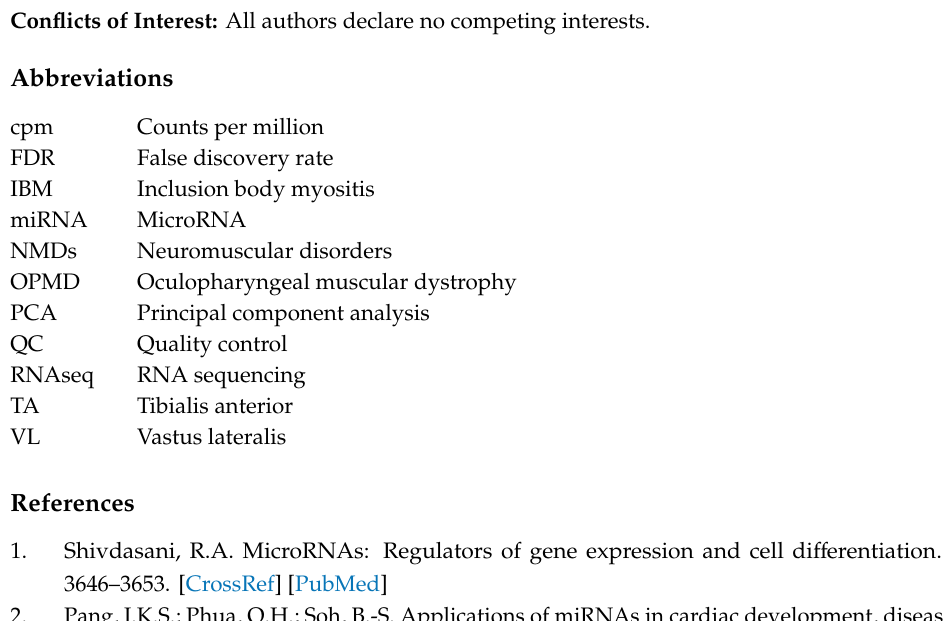
Table S1: Dataset demographics, Table S2: Gene lists of di ff erentially expressed miRNAs in human and mouse OPMD / OPMD model muscles, and OPMD-deregulated target genes to OPMD-deregulated miRNAs, Table S3: A table summary of miRNAs that are associated with muscle pathologies, Table S4: A table summary of miRNAs that are significantly associated with age in muscles from OPMD or controls, Table S5: An assessment of age or gender correlation with the OPMD-associated miRNAs in serum and saliva, Figure S1. RNAseq quality control, Figure S2. selection for miRNA candidates in saliva, Figure S3. qRT-PCR in saliva and serum samples. Author Contributions: Experimental design and funding for the study were made by V.R. and B.G.M.v.E.